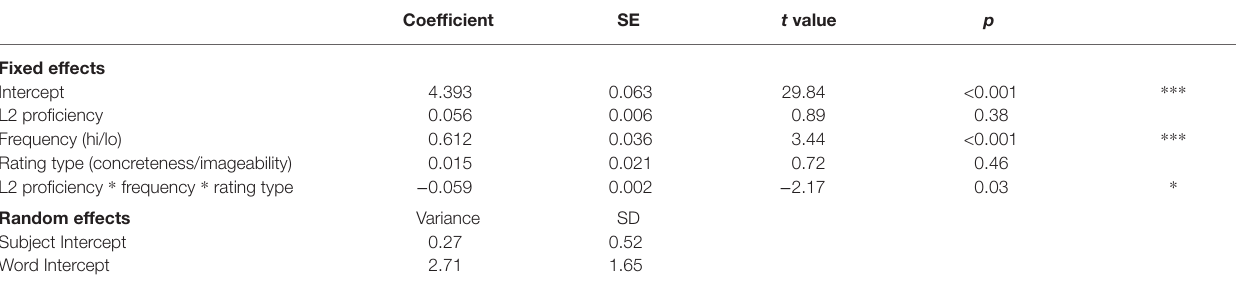
TABLE 5 | Linear-mixed effects regression model summary for frequency, imageability, and concreteness.